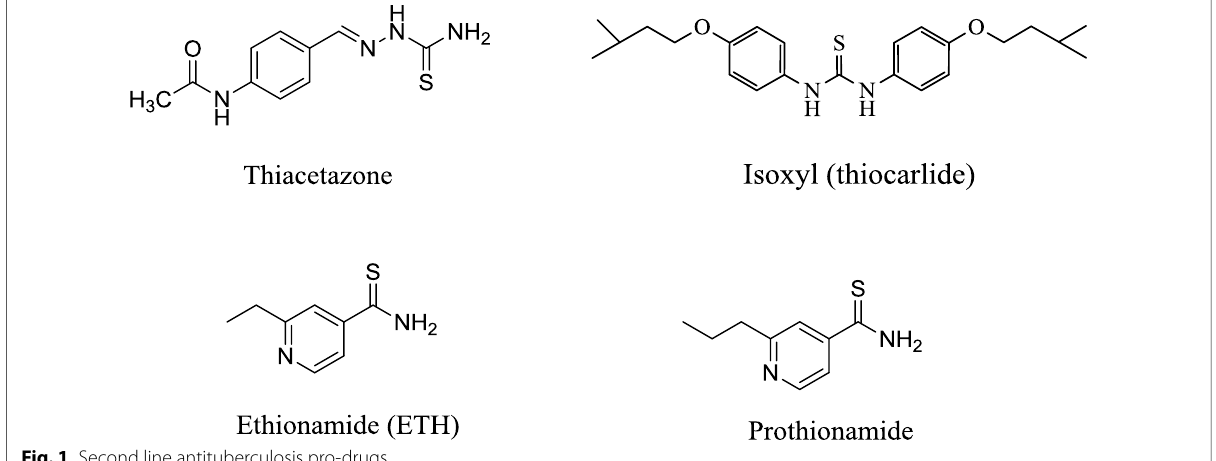
condensation of aromatic amines with N -(2,6-dimeth- oxypyrimidin-4-yl)-4-isothiocyanatobenzenesulfonamide 2 [27] in dioxane at reflux temperature in the presence of catalytic amounts of triethylamine, (Scheme 1). The structures of synthesized compounds 3a – t were con- firmed by the absence of characteristic absorption band at 2000–2200/cm (N C S). Also, the IR of 3 is character- = = ized by the presence of NH, thiocarbonyl (C S) and SO 2 = absorption bands. For example, the 1 H NMR spectrum of compound 3b showed two singlets at δ 3.81 and 3.84 ppm which were assigned for the two methoxy protons, a singlet at δ 6.1 ppm assigned to the pyrimidine-H, two downfield shifted singlets at δ 11.5 and 11.9 ppm which were readily assigned to the HN(1) and HN(2) protons, in addition to the presence of methyl, SO 2 NH and aromatic protons. The thiocarbonyl group of the thiourea moiety was also observed in the 13 C-NMR spectrum. The forma- tion of thioureas 3a – t can be explained through the previ- ously reported mechanism [24].